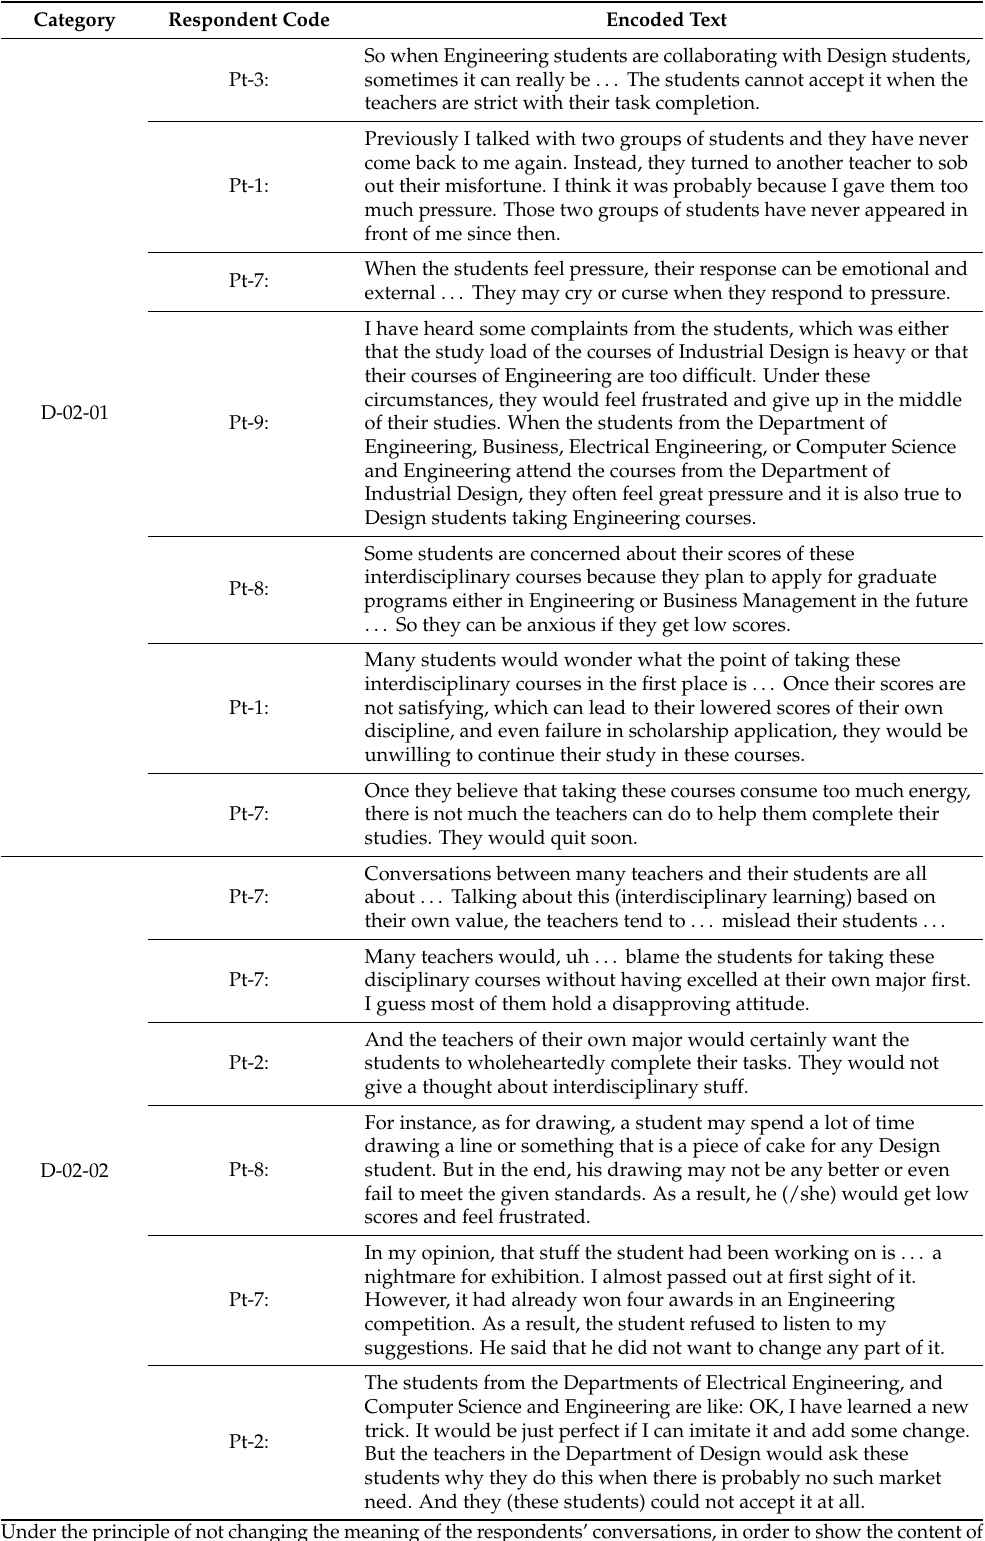
Table A3. Coding of D-02 interdisciplinary Learning